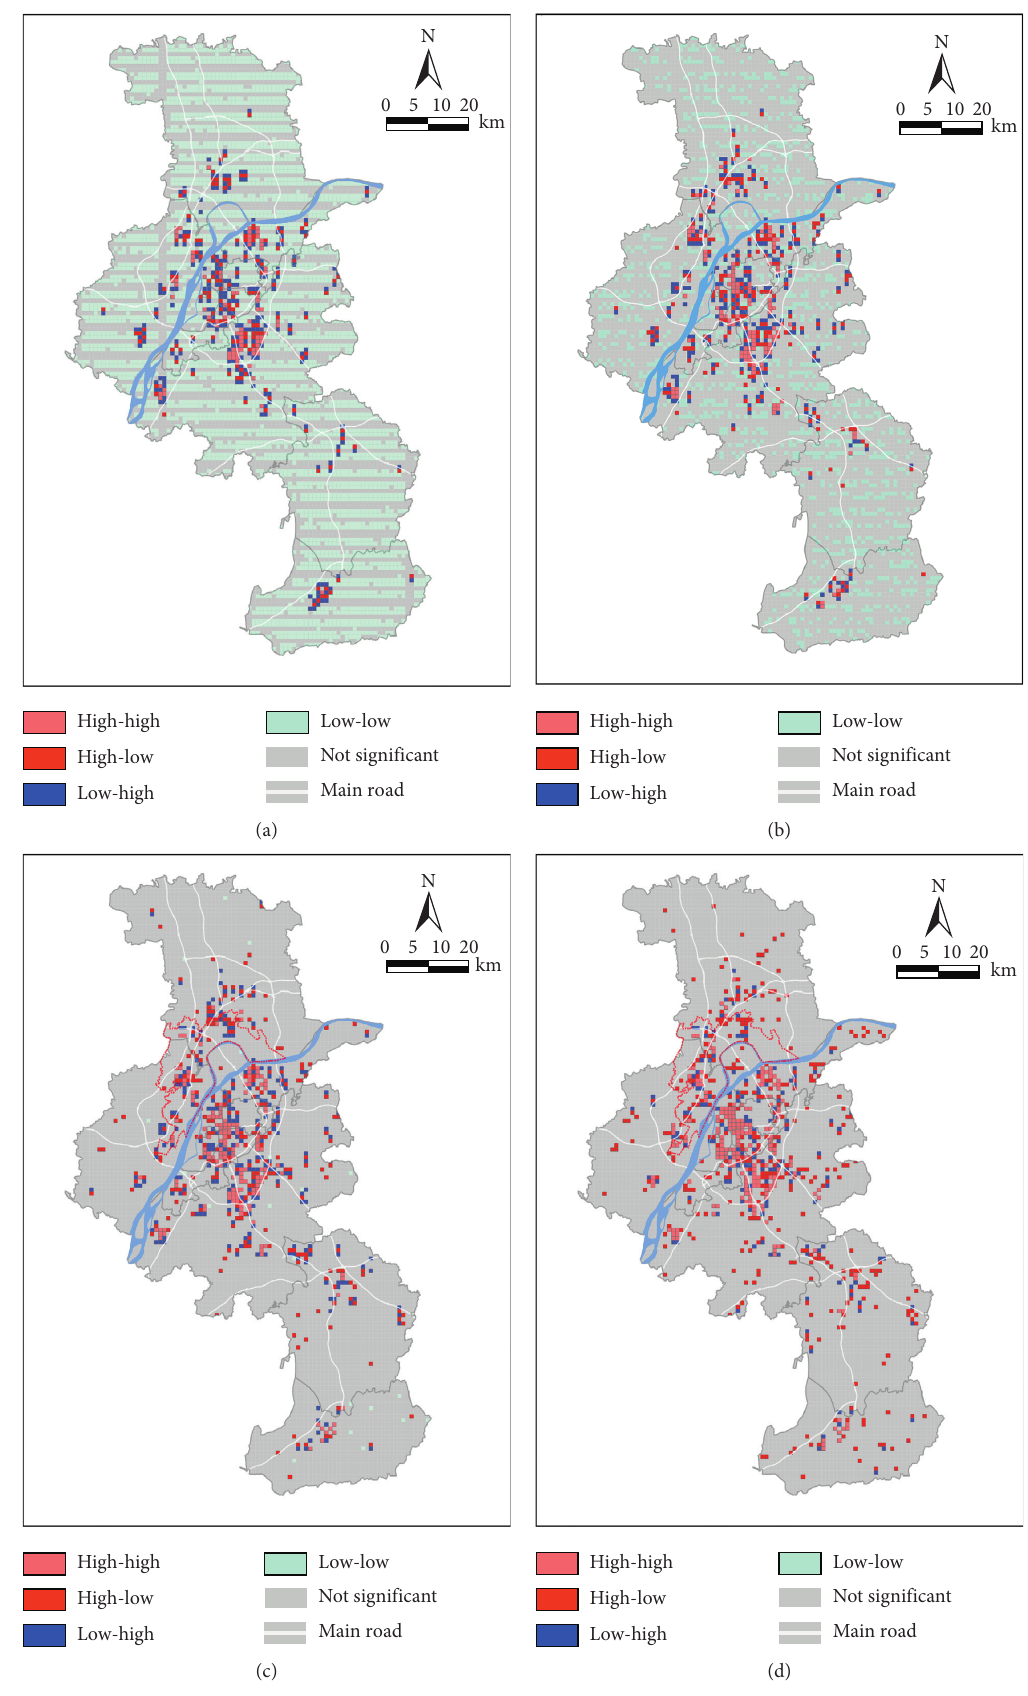
Figure 4: LISA agglomeration map of urban innovation space in Nanjing: (a) 2008–2010; (b) 2011–2013; (c) 2014–2016; (d)